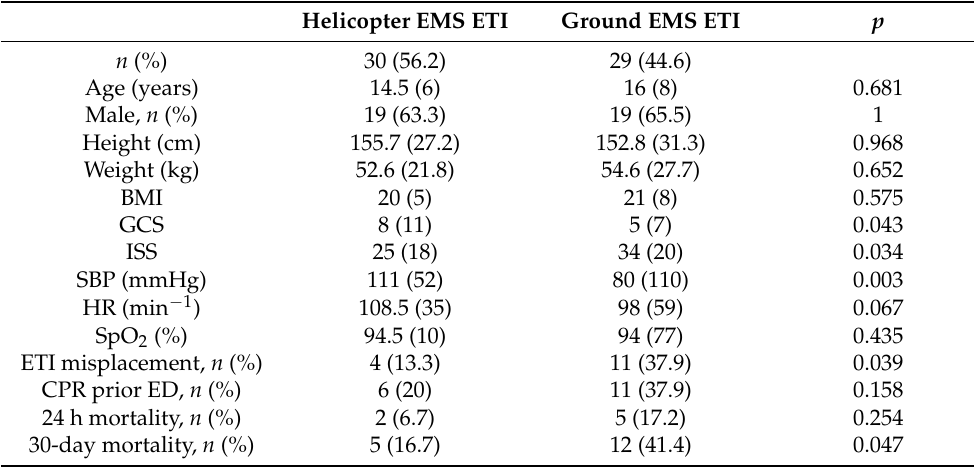
Table 4. Comparison of helicopter EMS vs. ground EMS characteristics of the study